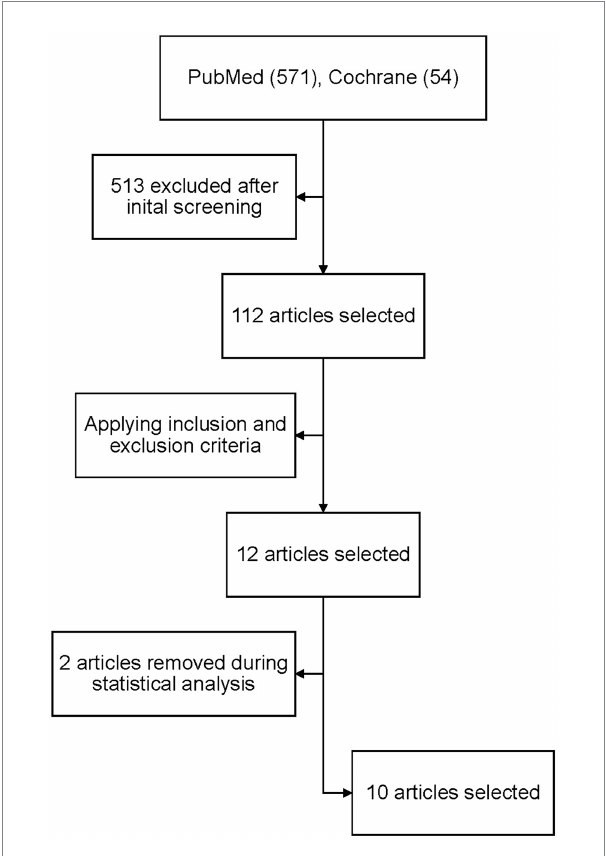
FIGURE 1 PRISMA flow diagram for the number of studies screened, assessed for eligibility, and included in the